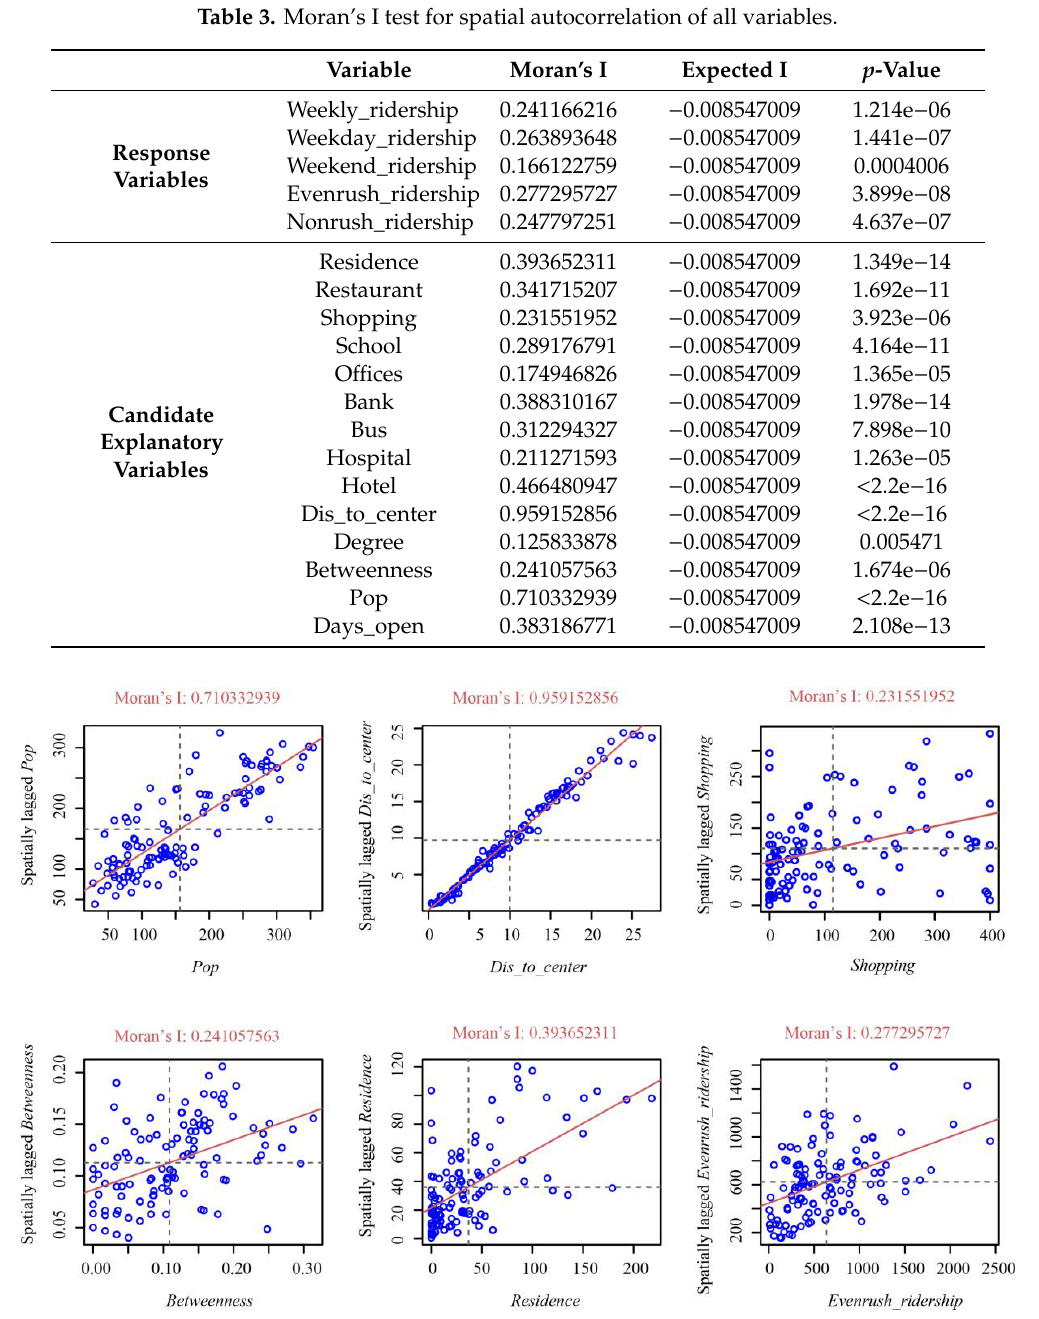
Figure 3. Moran scatter plots of explanatory variables.